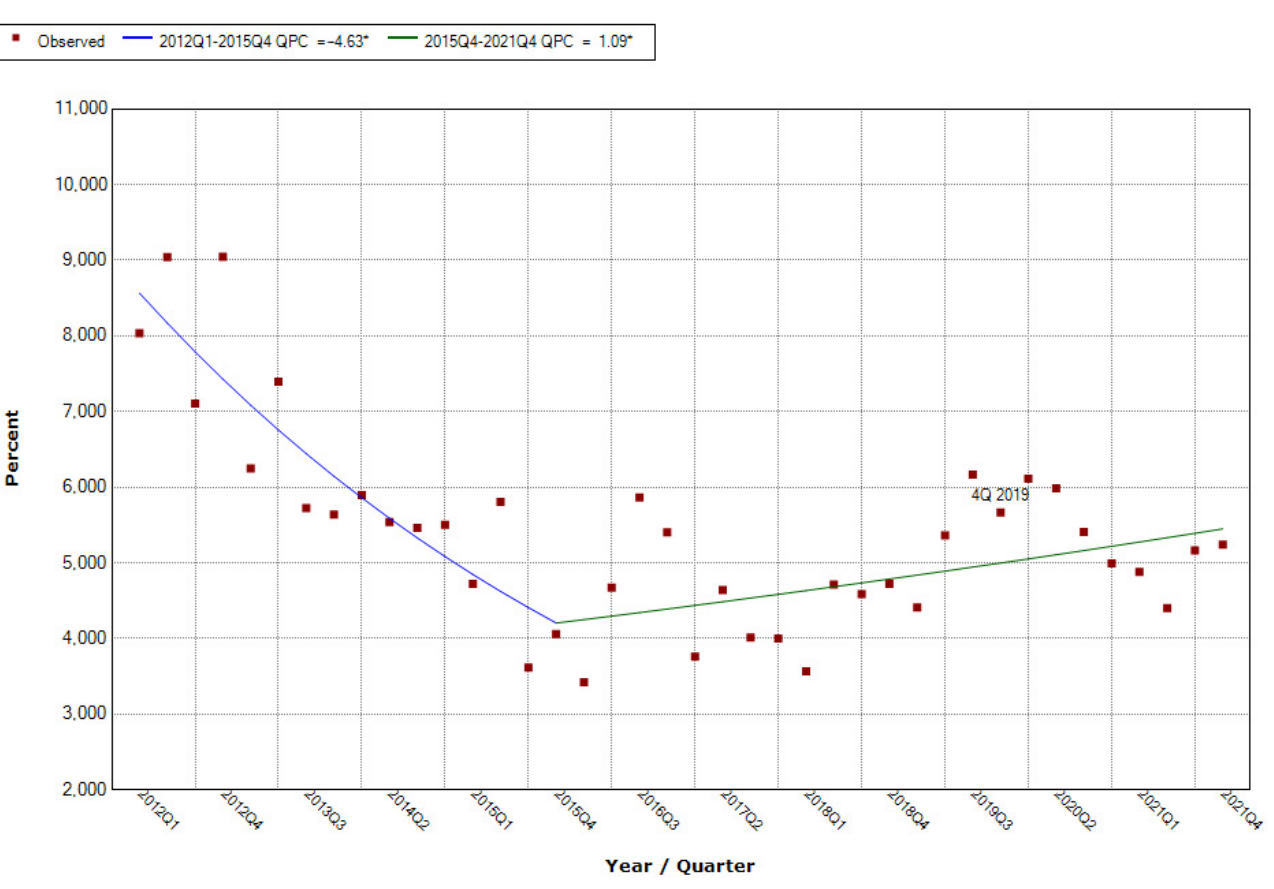
Figure A20. Percentage of products containing iron in individual quarters in the period from 2012 to 28 November 2021. Joinpoints mark trend turning points. The date above the observation indicates the moment of publication of the scientific opinion/resolution.